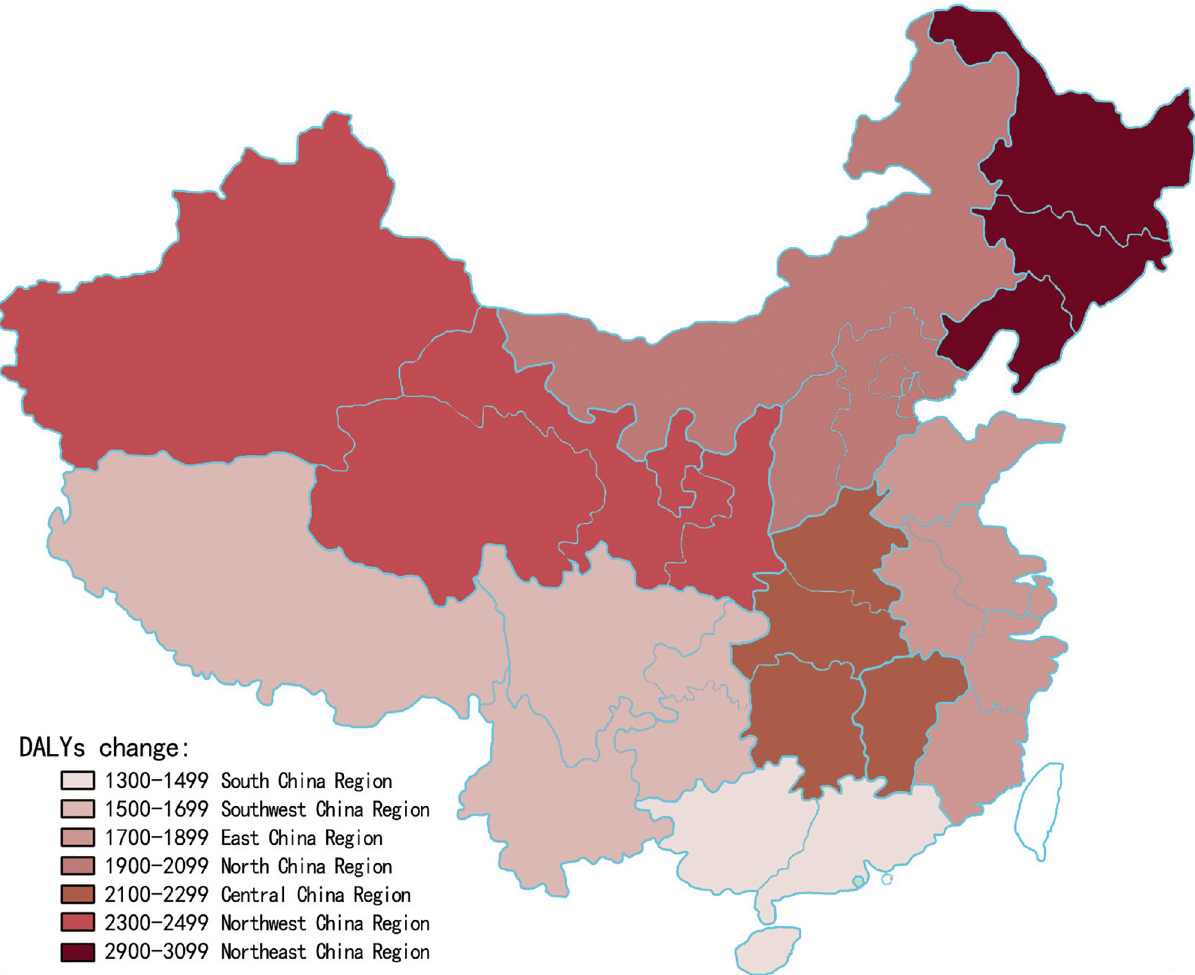
Fig 1. DALYs per 100,000 people in seven regions of China. The region with the highest DALYs rates was Northeast while the lowest DALYs rates were in South China.